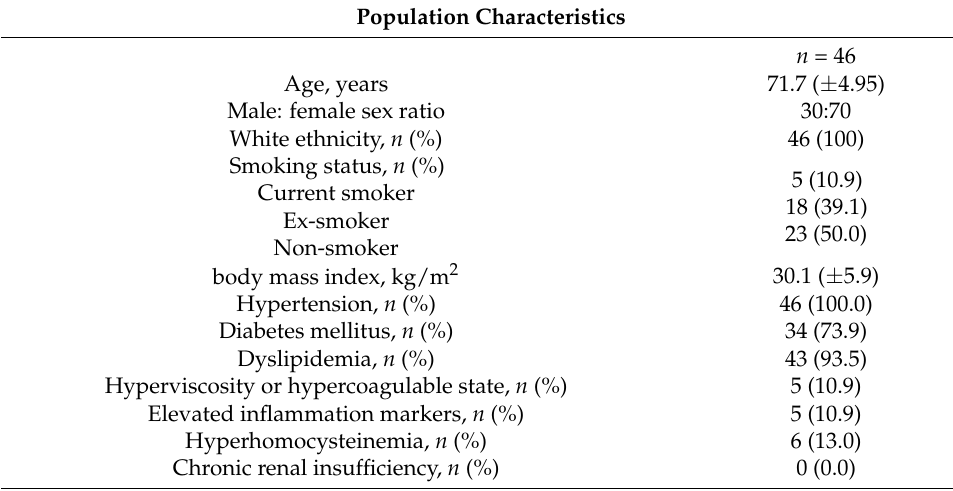
Table 1. Population